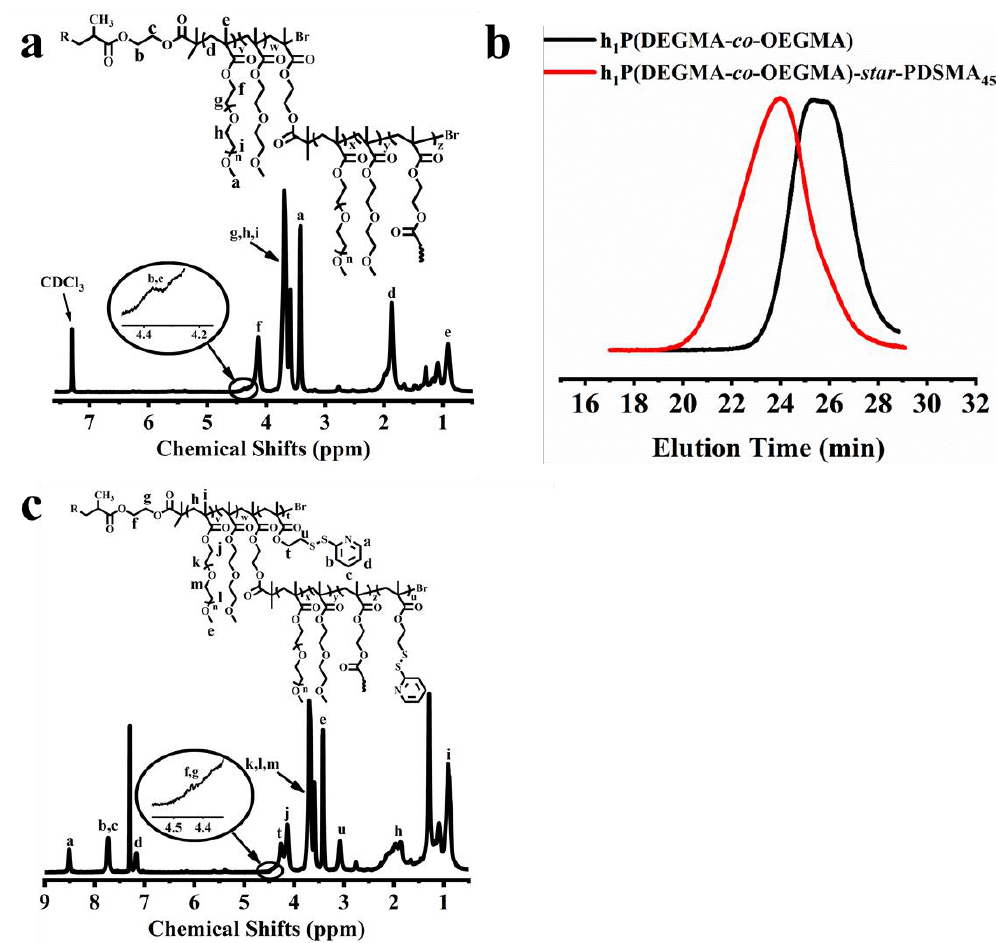
Figure 1. ( a ) 1 H NMR spectrum of h 1 P(DEGMA- co -OEGMA) in CDCl 3 , ( b ) GPC curves of h 1 P(DEGMA- co -OEGMA) (black line) and h 1 P(DEGMA- co -OEGMA)- satr -PDSMA 45 (red line). ( c ) 1 H NMR spectrum of h 1 P(DEGMA- co -OEGMA)- satr -PDSMA 45 in CDCl 3. Table 3. Structure data of the three hyperbranched polymers. h 1 P(DEGMA- co - h 2 P(DEGMA- co - h 3 P(DEGMA- co - OEGMA) OEGMA) OEGMA) Feeding ratio of BMA to OEGMA ( M n = 300), DEGMA 1:3:7 1:2.4:5.6 1:1.5:3.5 ( M n = 188)